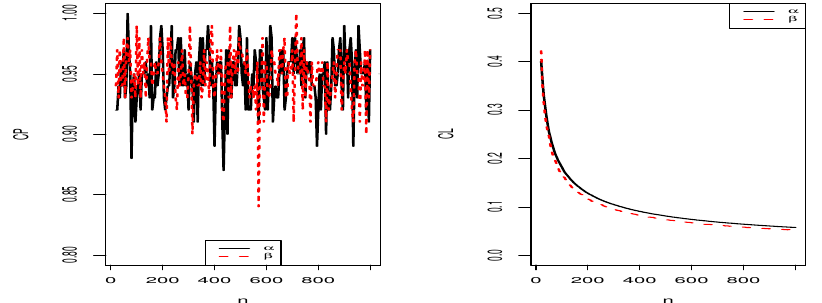
Figure 5. The empirical CLs and CPs of the MLEs for the